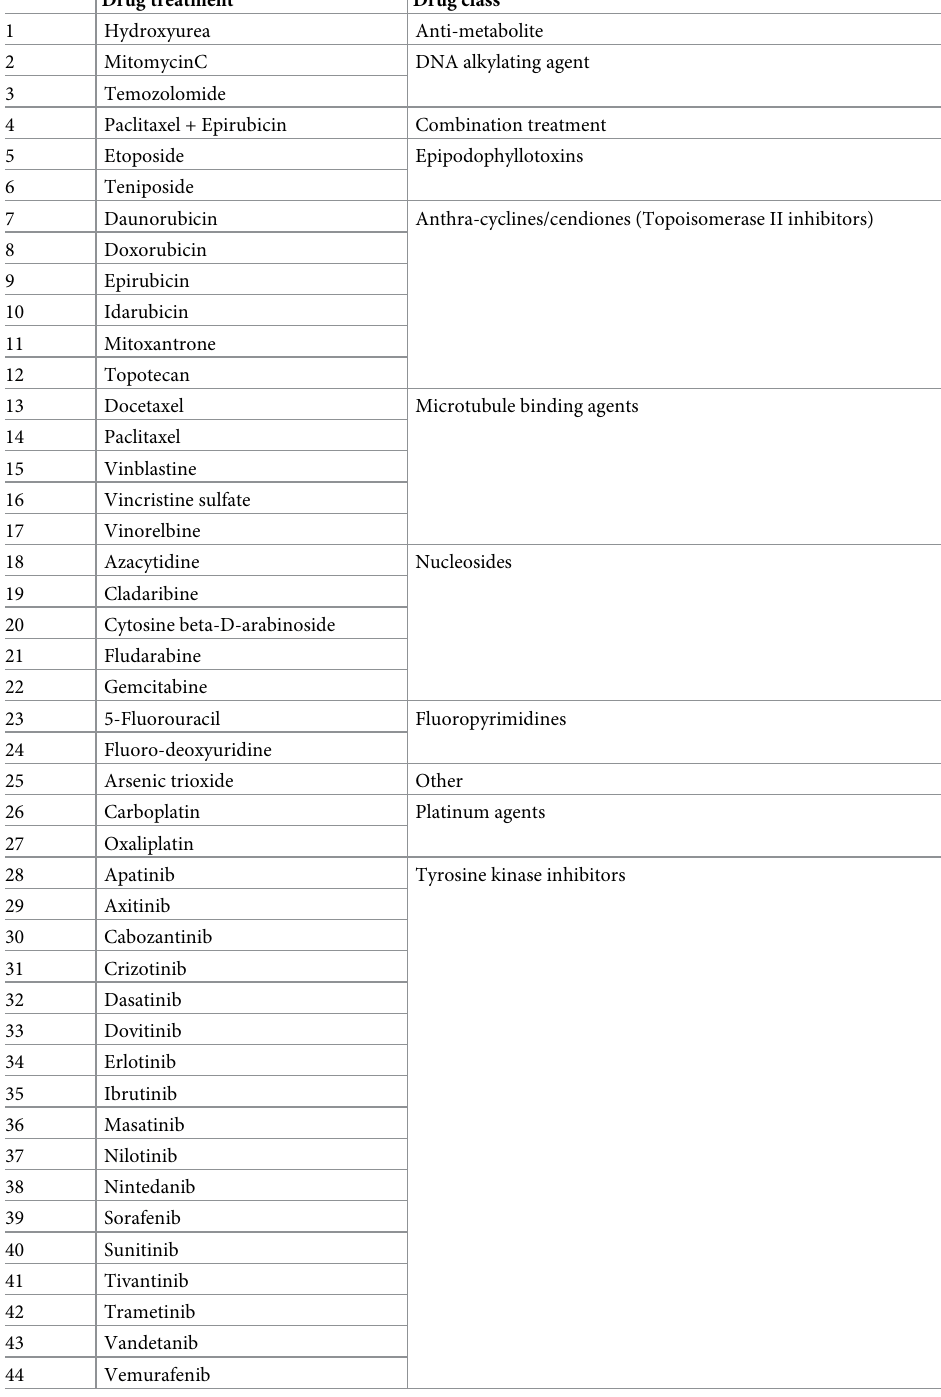
Table 1. Anticancer drug treatments used for the drug-response assays by drug